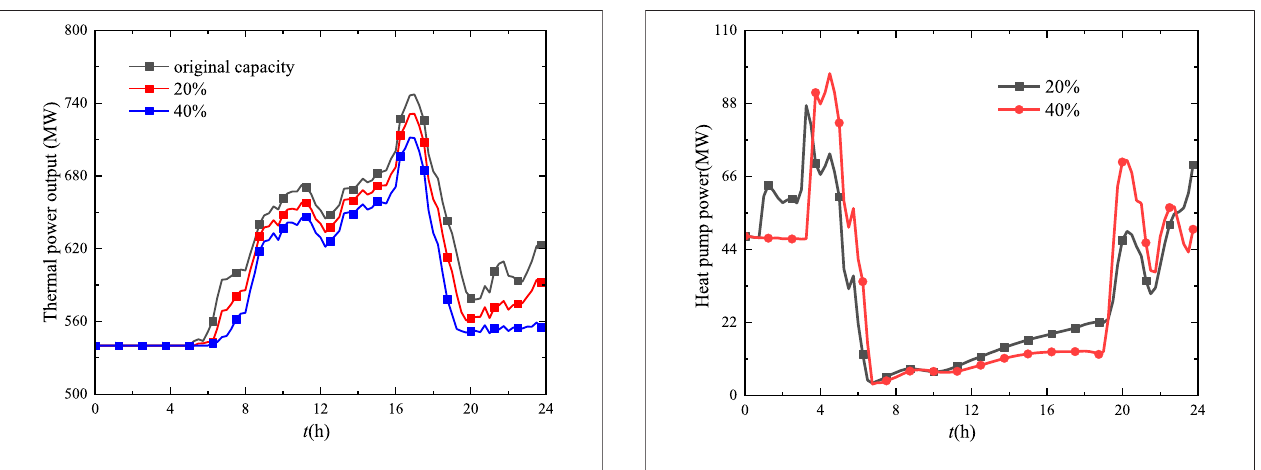
FIGURE11 | Variations ofpower consumption oftheheatpump varying with the new wind power installed capacity.